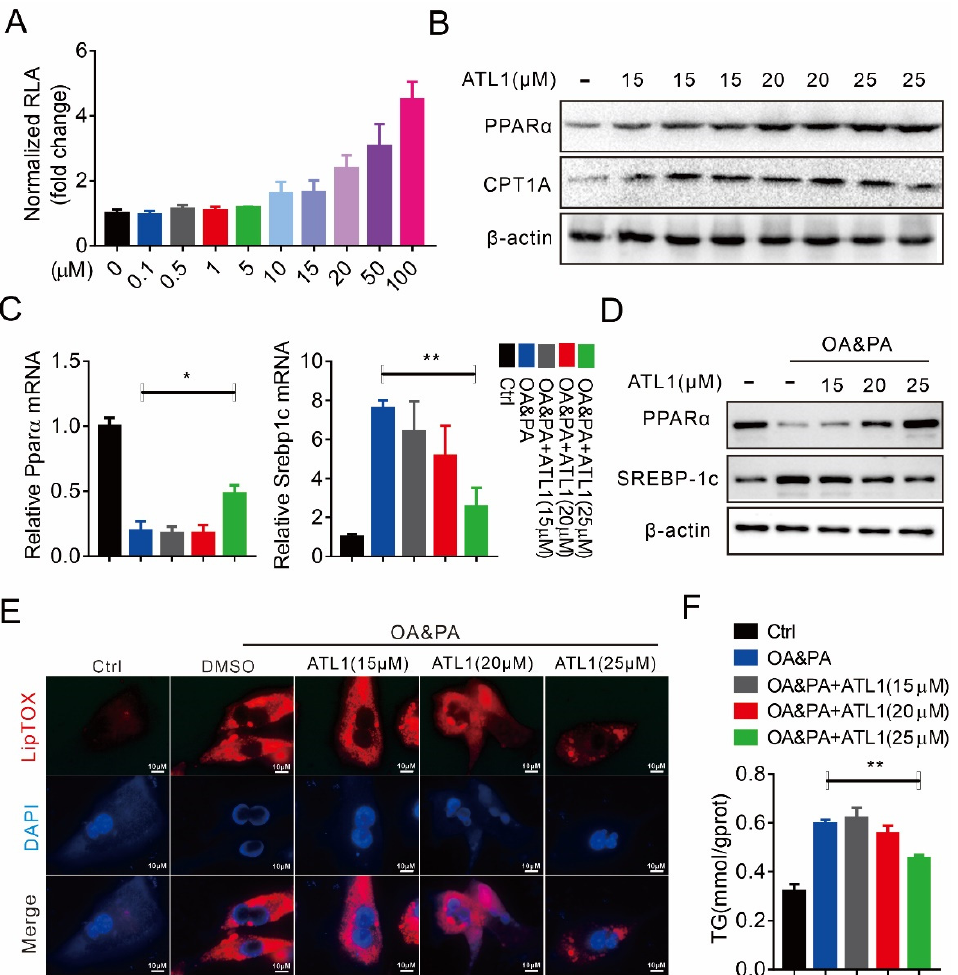
Figure 1. ATL I treatment alleviates lipid accumulation in vitro. ( A ) Luciferase reporter assays indicated that ATL I treatment effectively stimulated PPAR α expression in HepG2 cells in a dosage- dependent manner. ( B ) ATL I treatment significantly increased the protein levels of PPAR α and its target genes. ( C , D ) ATL I treatment effectively reversed the mRNA ( C ) and protein ( D ) levels of PPAR α and SREBP-1c in OA&PA cultured MPHs. ( E ) LipidTOX assays indicated an effective reduction in lipid deposition in OA&PA treated MPHs after ATL I treatment. ( F ) ATL I treatment effectively decreased the TG contents in MPHs. Results are shown as mean ± SEM (n ≥ 3). * p < 0.05, ** p < 0.01 versus the OA&PA group.